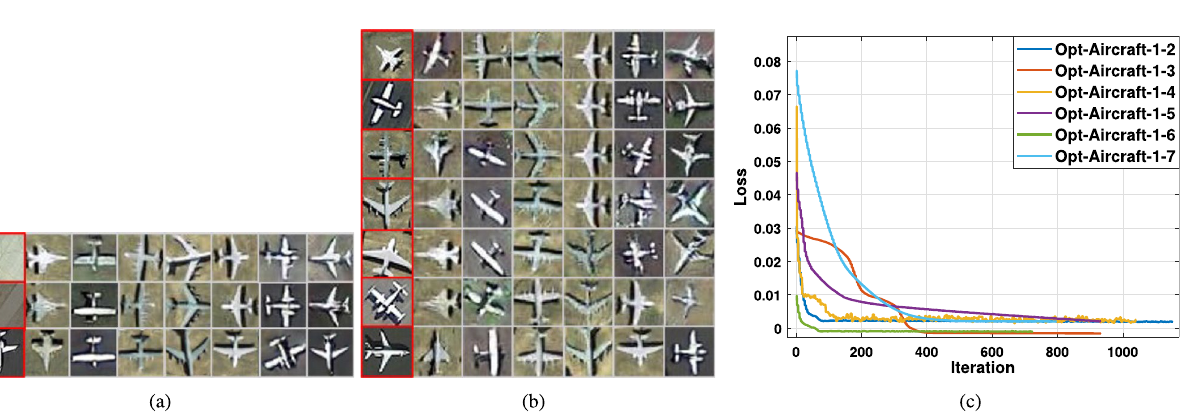
Figure 9. Embedding results and loss value on OPT_Aircraft-7 datasets. ( a ) Each row displays the embedded results from the various ground-truth samples mapped to seven aircraft types, respectively. ( b ) Embedding results on input seven aircraft types samples. The red box represents the ground-truth 32 pixels images. The corresponding rows denote that converted to other classes in turn. ( c ) Loss values vs. the number of optimisation steps on